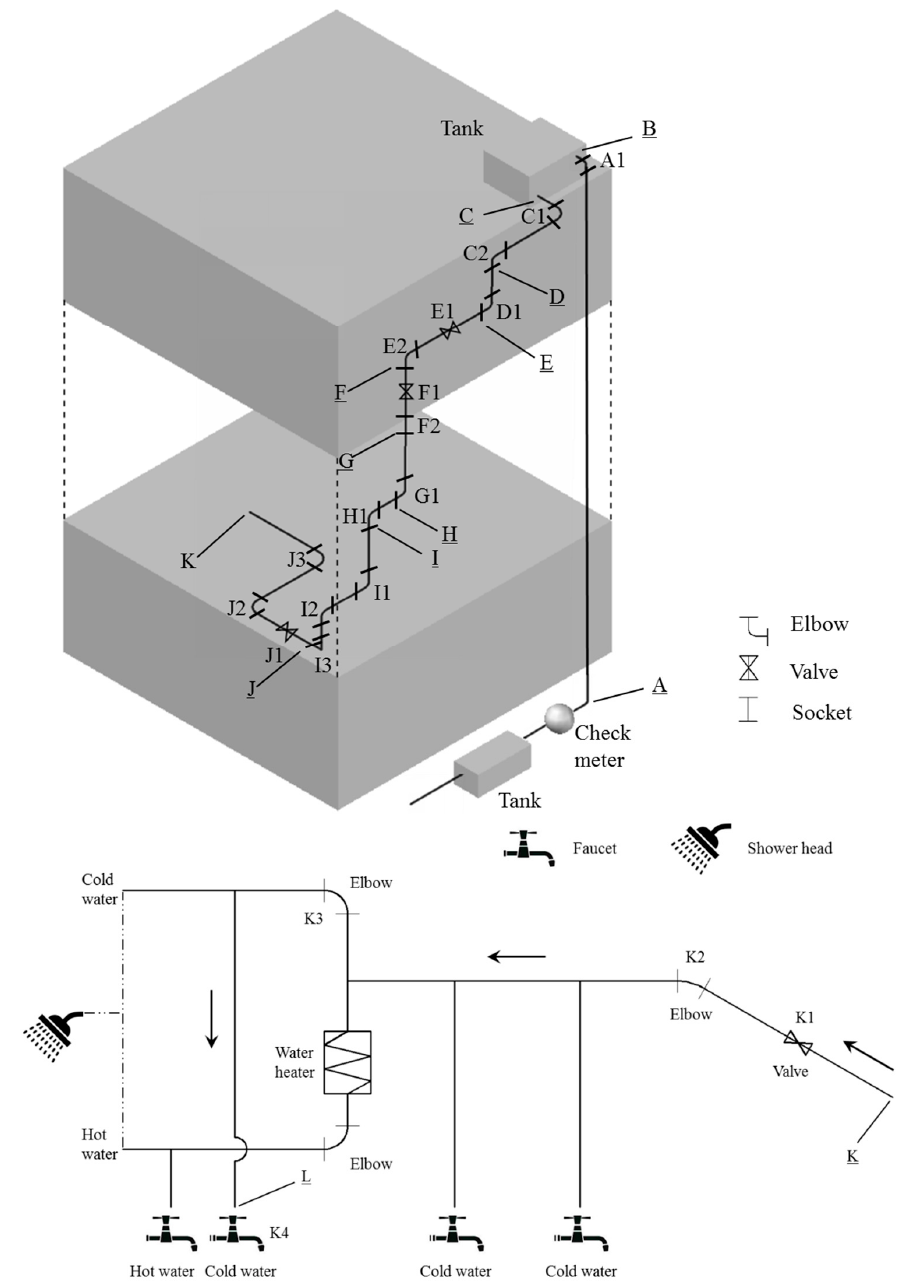
Figure 2. A simplified schematic diagram of the plumbing installation.